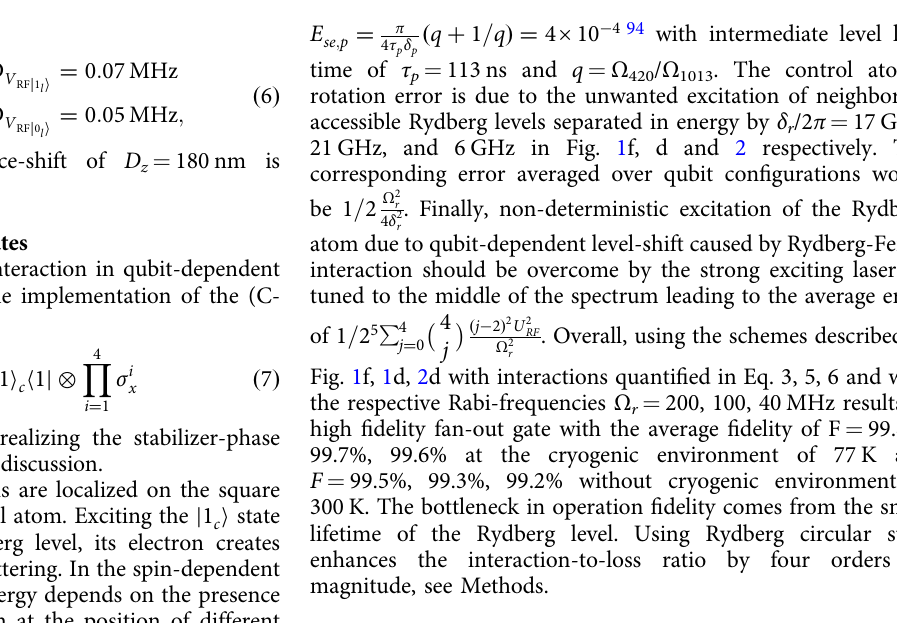
(cid:1) (cid:3) (cid:1) state to the Rydberg level. The Fermi scattering of the 1 t